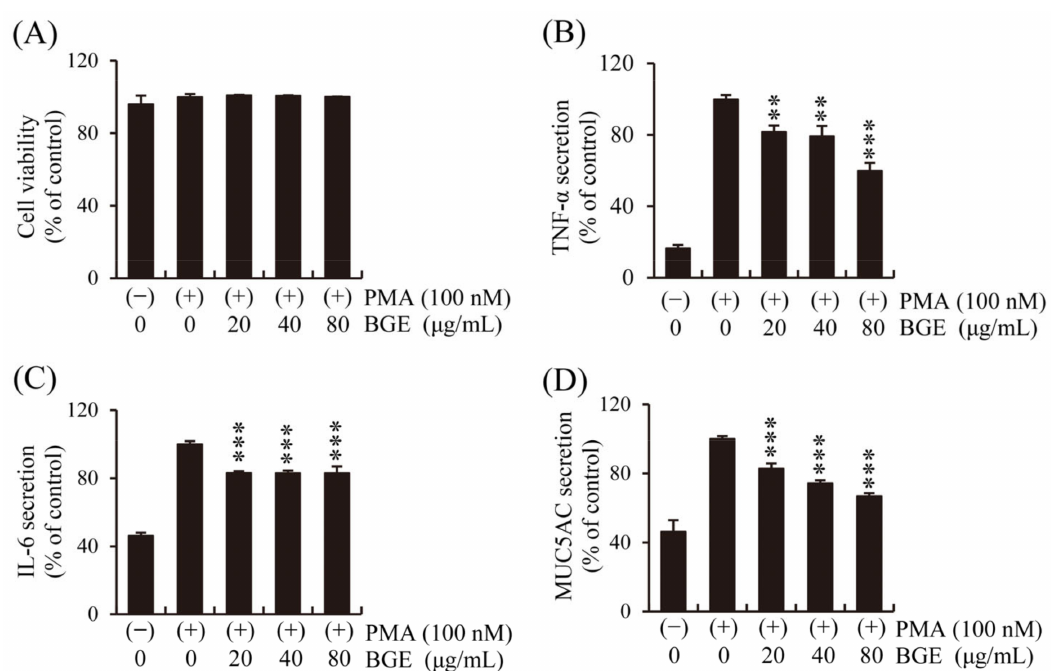
Figure 3. Effects of the BGE on PMA-induced increase in TNF- α , IL-6, and MUC5AC secretion in human airway epithelial (NCI-H292) cells. Cells were pre-treated with the corresponding concentra- tion for 2 h and subsequently exposed to PMA (100 nM) for 16 h. ( A ) NCI-H292 cell viability was assessed using the CCK-8 method. ( B – D ) TNF- α , IL-6, and MUC5AC levels were determined using ELISA kits. Bar graphs represent means ± S.D. in triplicate in one representative experiment from three independent experiments (** p < 0.01, and *** p < 0.001 for comparison with controls, which were treated with PMA